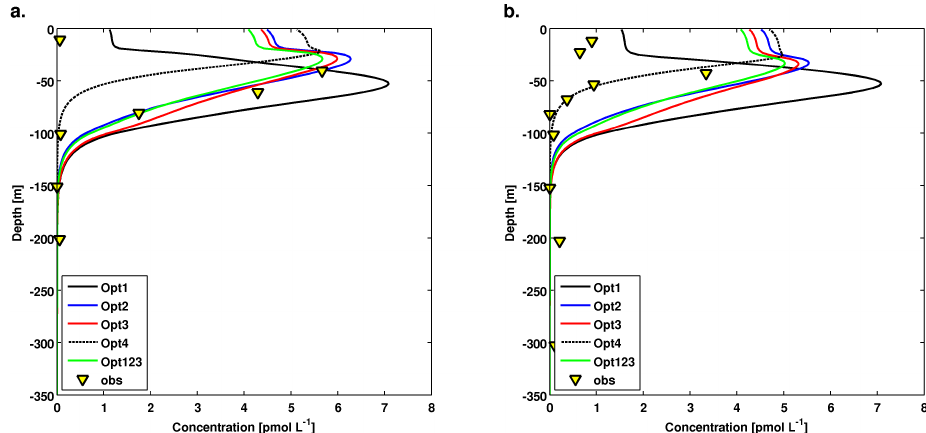
Fig. 4. Methyl iodide concentration profiles [pmolL − 1 ] from stations CVOO and St. 308 in the Cape Verde region. Observed data were collected during Poseidon cruise P399/2 in 2010. For the CVOO station only data from the upper 350m of the water column are shown.